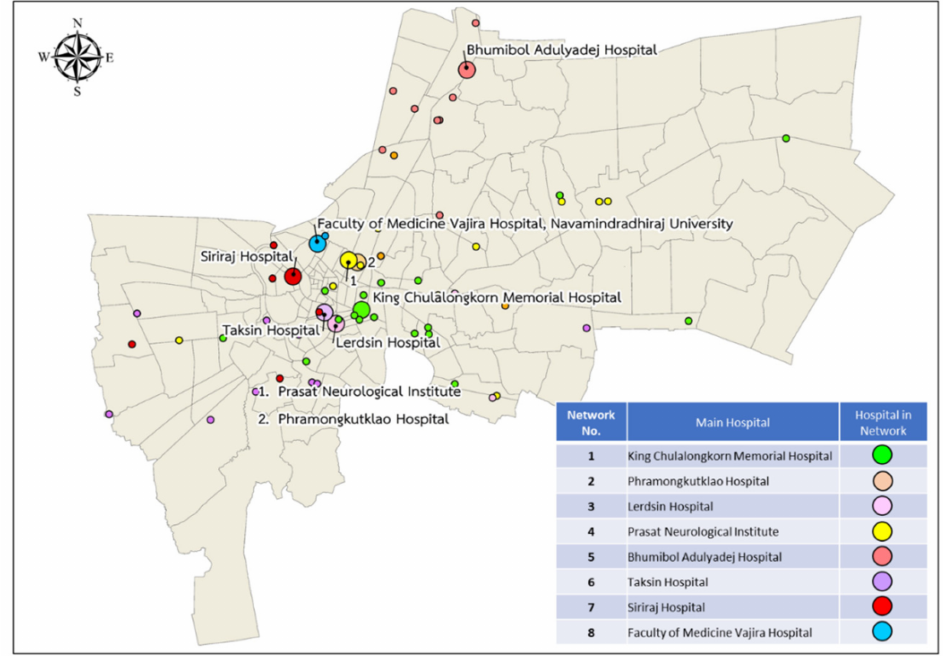
Figure 4. Hospitals with networks in the Stroke Service Plan of NHSO Region